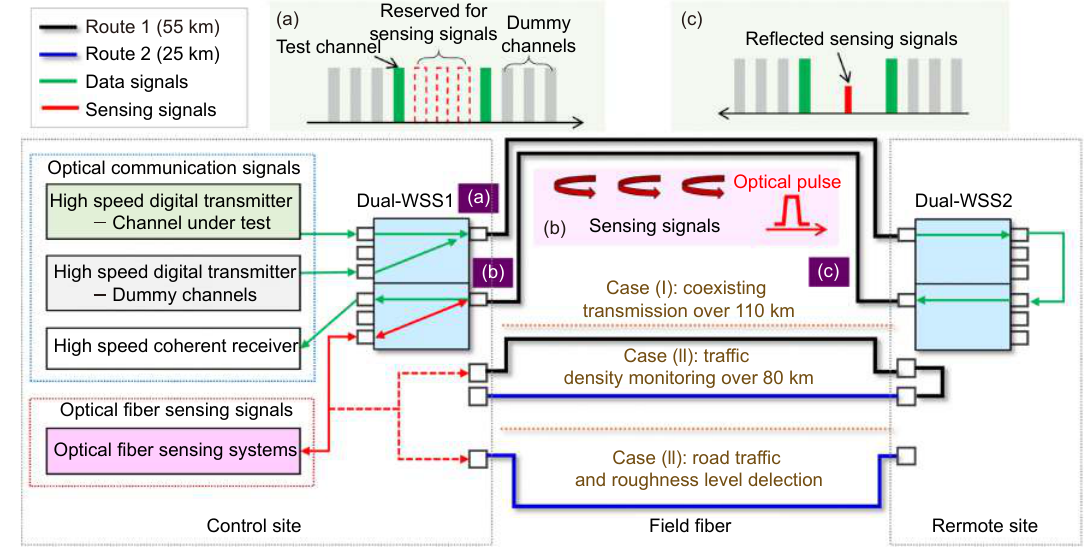
Fig. 11 | Integration of Φ-OTDR system in the DWDM communication network. Figure reproduced with permission from ref. 116 ,